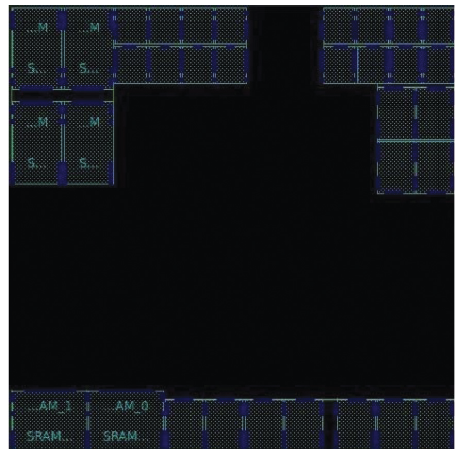
Figure 2: Simulated architecture with